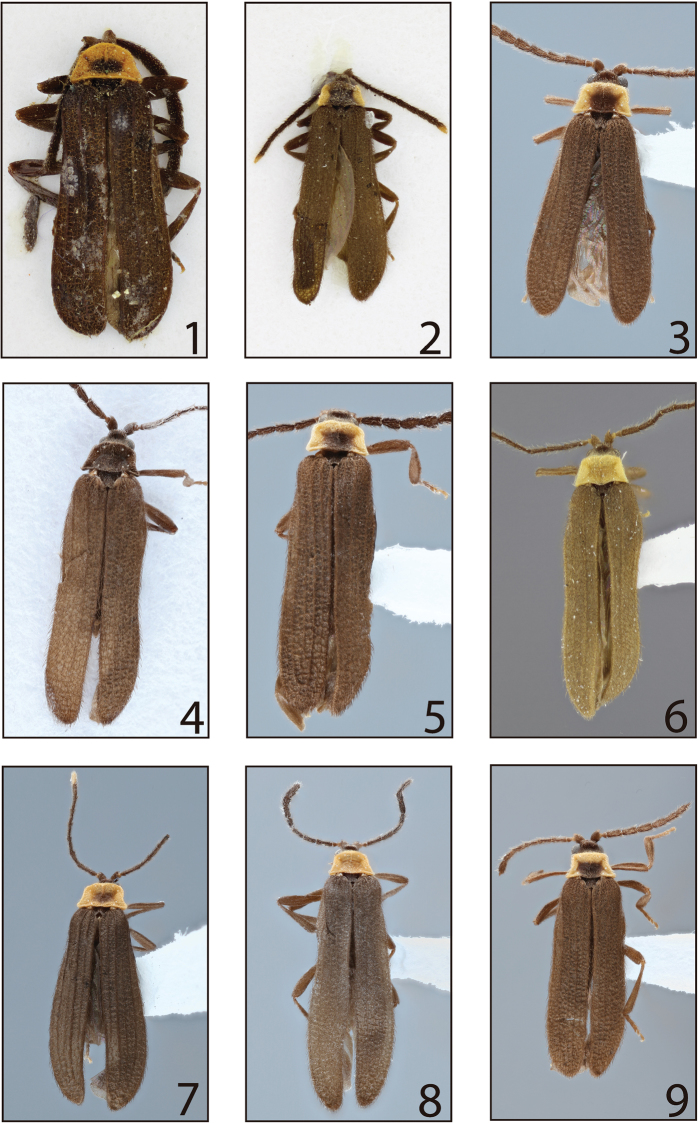
Dorsal habitus of Lycinella. 1L.opaca Gorham, 1884 (lectotype) 2L.parvula Gorham, 1884 (lectotype) 3L.parvula4L.adamantis5L.hansoni6L.milleri7L.cidaoi8L.marshalli9L.pugliesae.